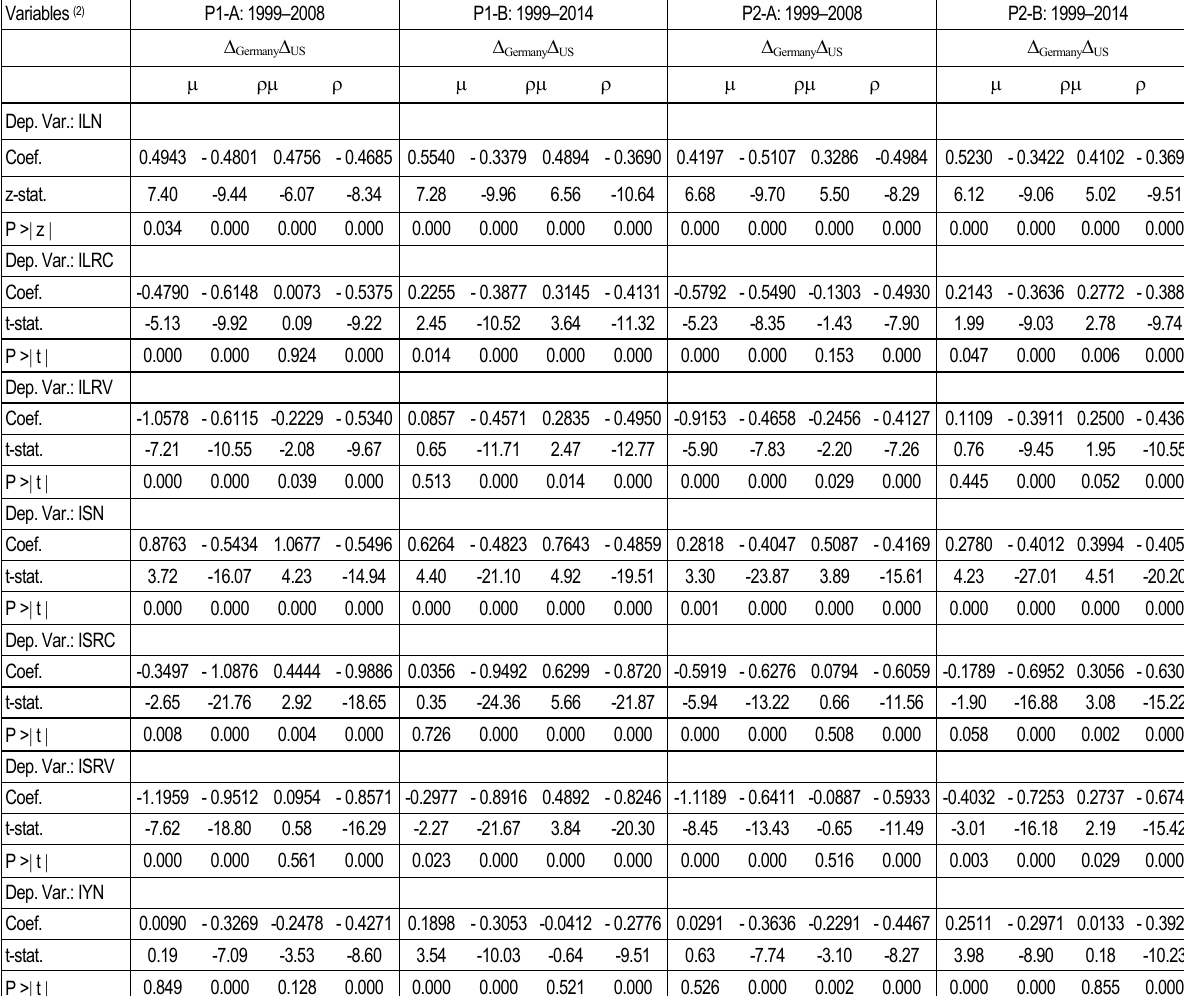
Table 2. Sigma convergence results PANEL 1- 35 developed countries (1) PANEL 2 – 28 EU